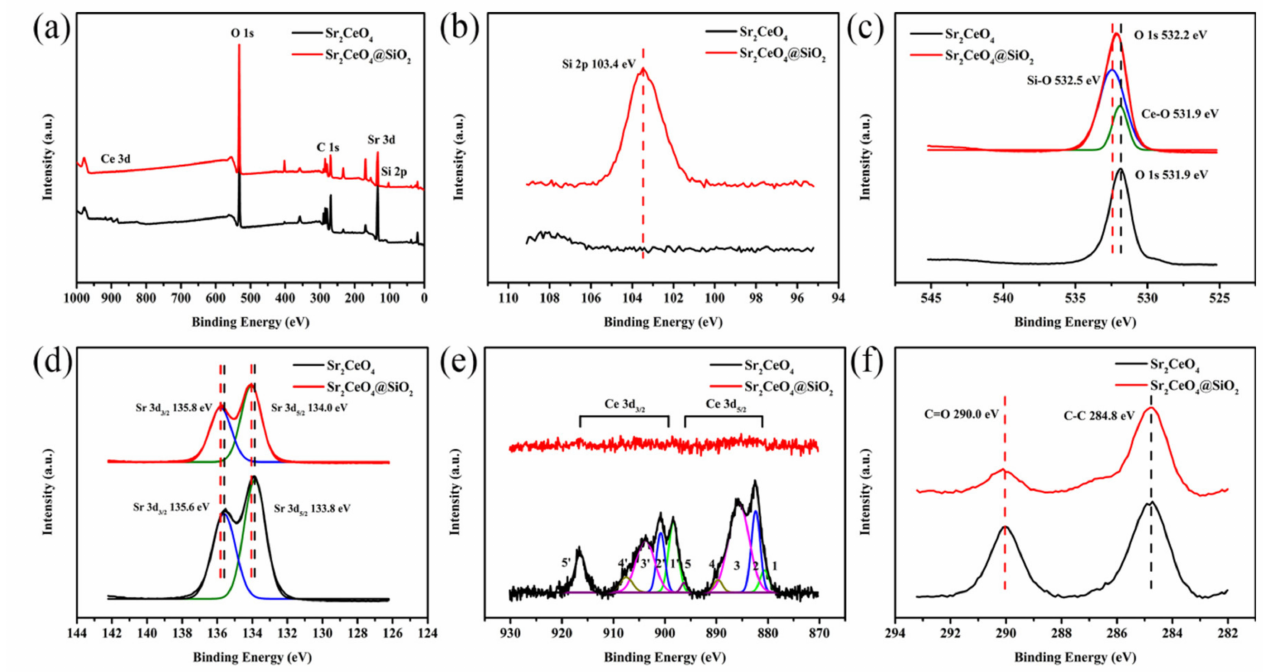
Figure 3. ( a ) XPS survey spectra of full spectrum; ( b ) Si 2p; ( c ) O 1s; ( d ) Sr 3d; ( e ) Ce 3d; ( f ) C 1s spectrum of Sr 2 CeO 4 and Sr 2 CeO 4 @SiO 2